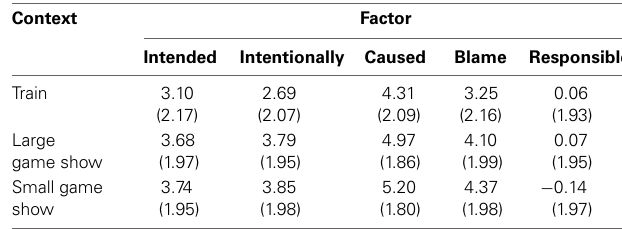
Table 1 | Mean (and standard deviation) of factor ratings in the scenarios.